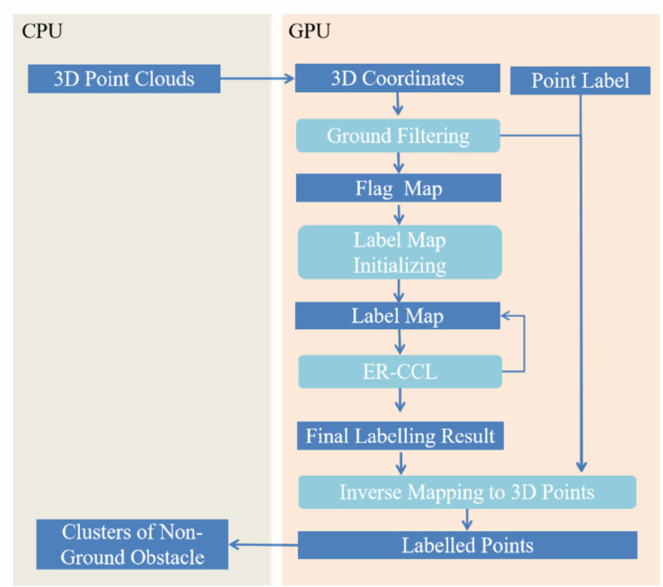
Figure 3. GPU accelerated framework for obstacle labeling in 3D point